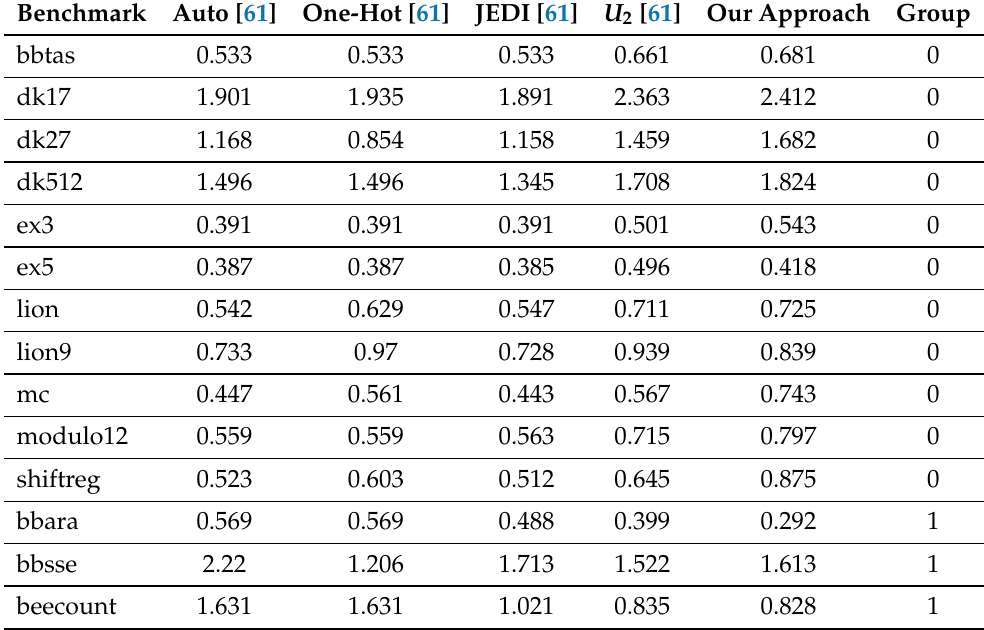
Table 18. Experimental results (total on-chip power,